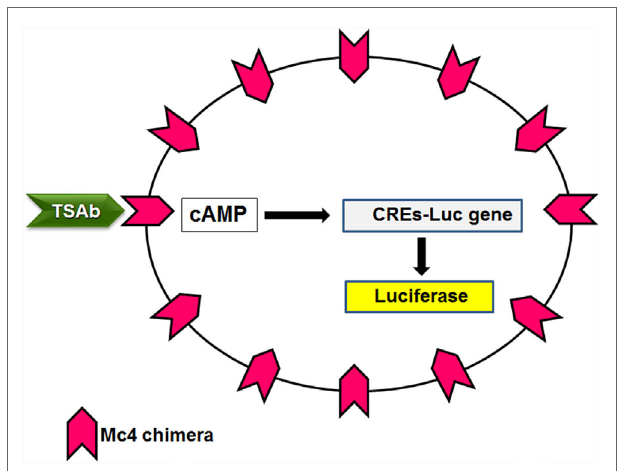
FiGURe 4 | Principle of the Mc4 bioassay . Cell lines lacking TSHR are double transfected with a luciferase reporter gene under the transcriptional control of multiple cAMP-responsive elements (CREs-Luc) and the Mc4 chimeric receptor. TSAbs levels in patient sera are determined by measuring the increased production of